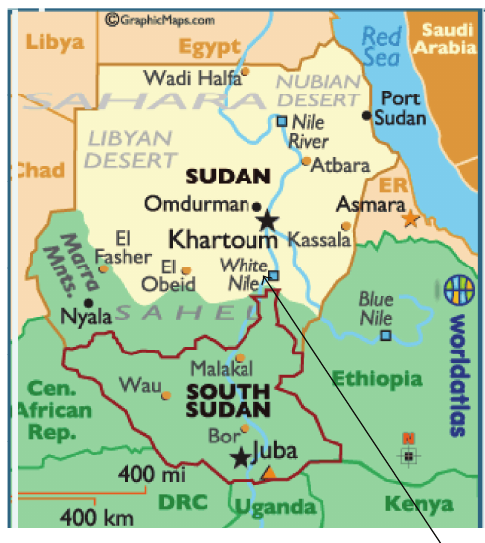
Figure 1: Map of the